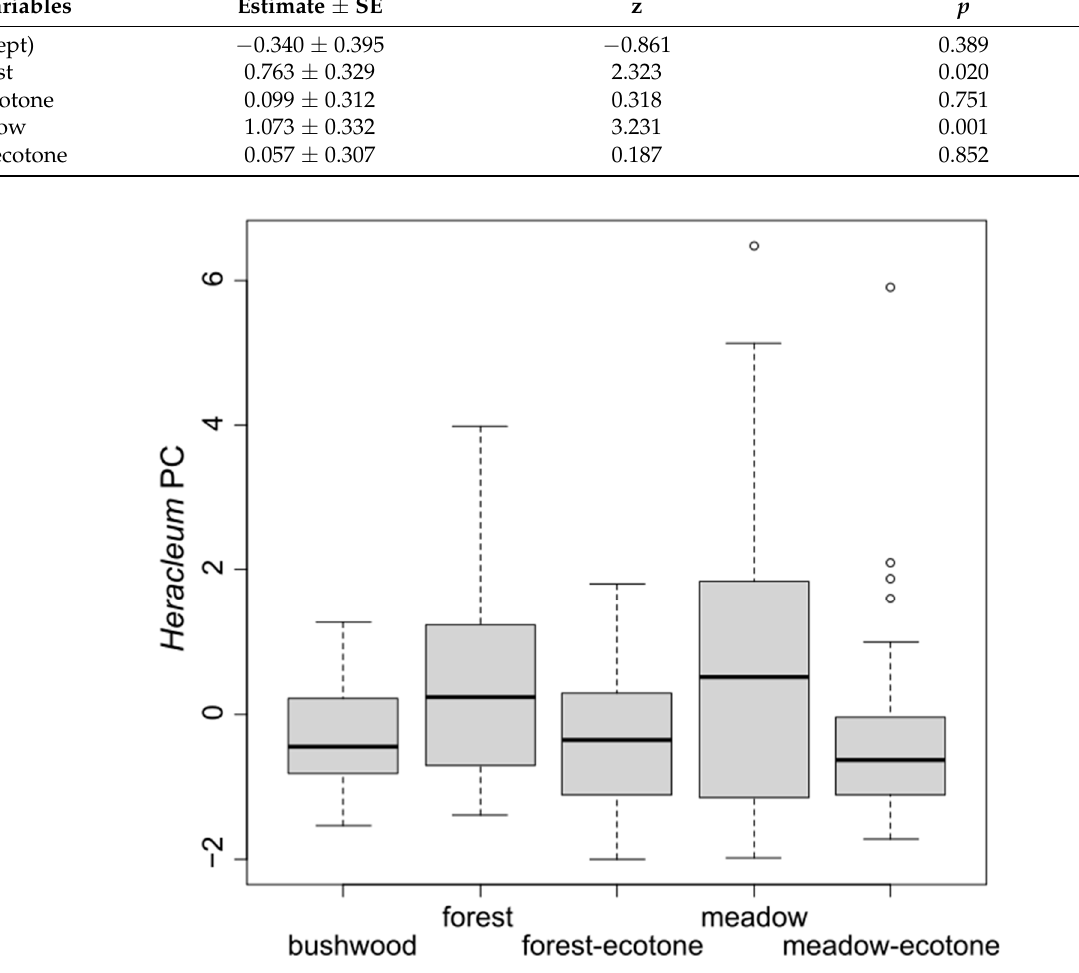
Figure 6. The performance of Caucasian hogweeds’ invasiveness traits in habitat